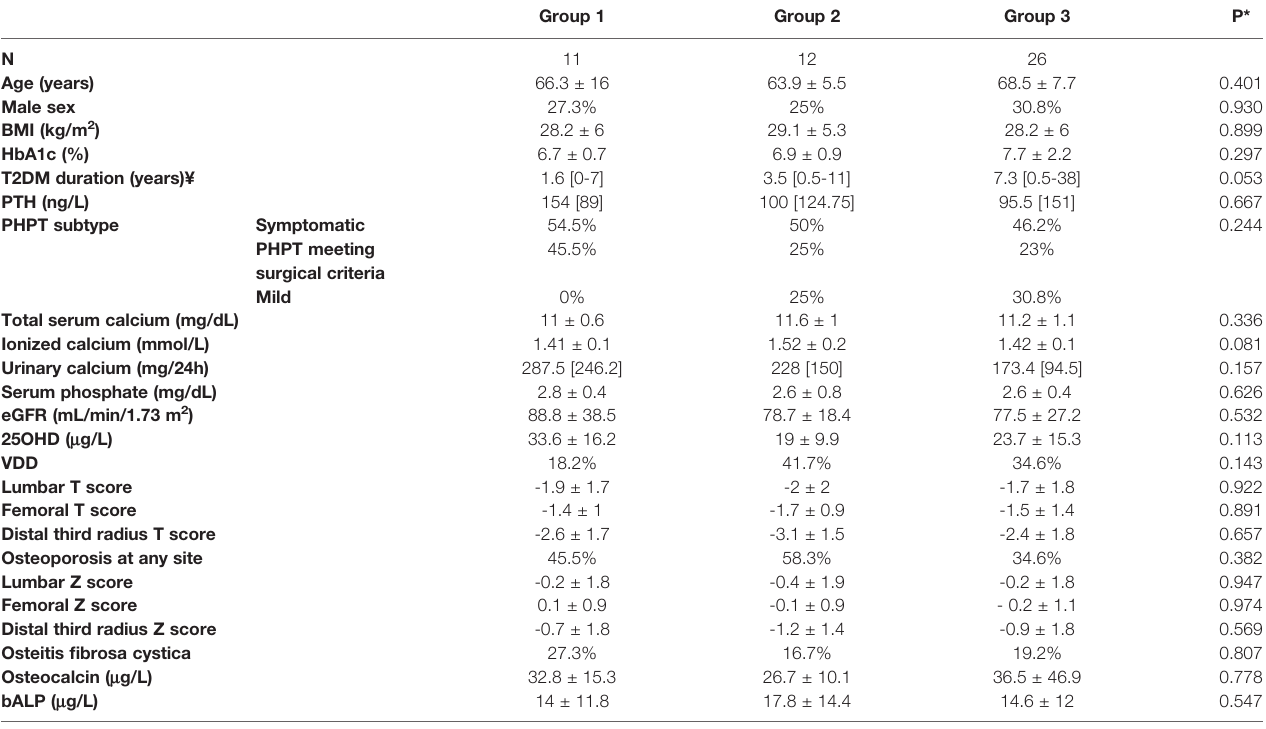
TABLE 2 | Data of PHPT patients with T2DM grouped according to antidiabetic treatment §